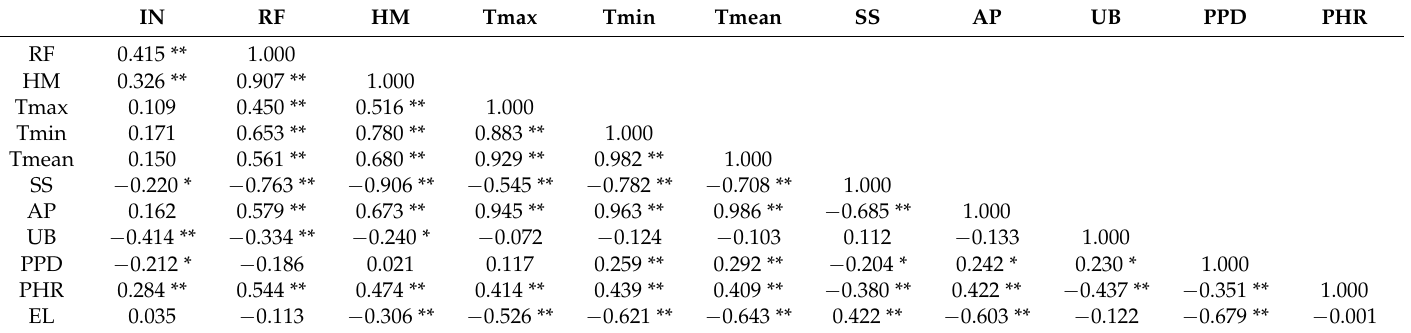
Table 3. Spearman correlations of JE incidences and socio-climate variables in Shaanxi, China